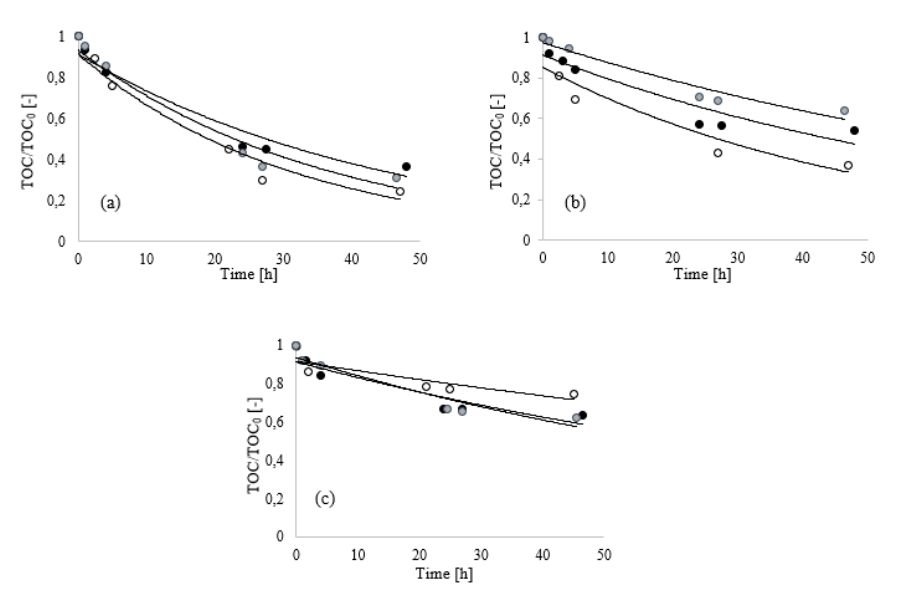
Figure 3. TOC removal trends (Blackman equation) during accelerated biodegradation tests of the conditioning mixture A ( a ), B ( b ) and C ( c ) with 2.0 mL of Bacillus Clausii at different dosages as 0.10% (gray), 0.13% (black) and 0.20% (white). Conditions: pH = 6 and 30 °C.